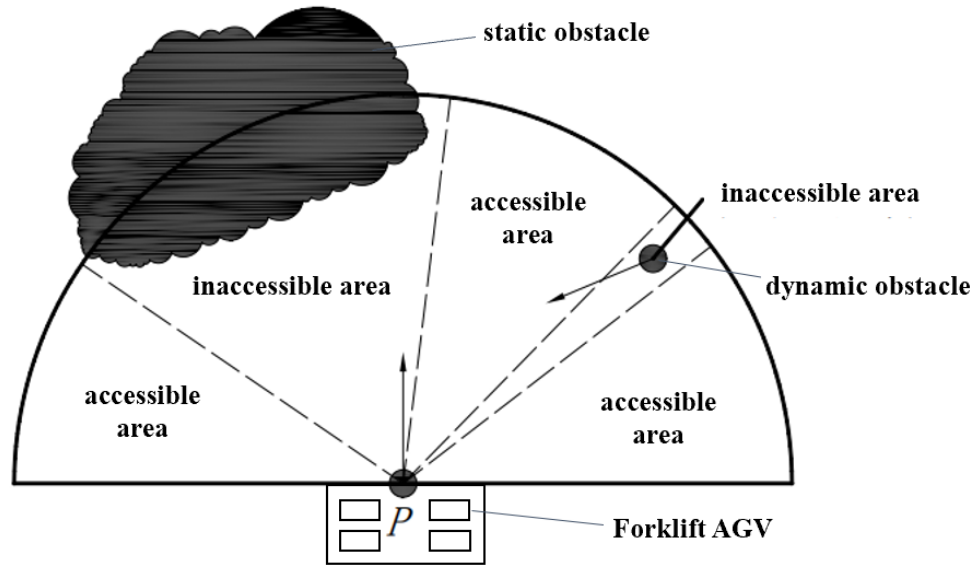
Figure 5. Reachable area